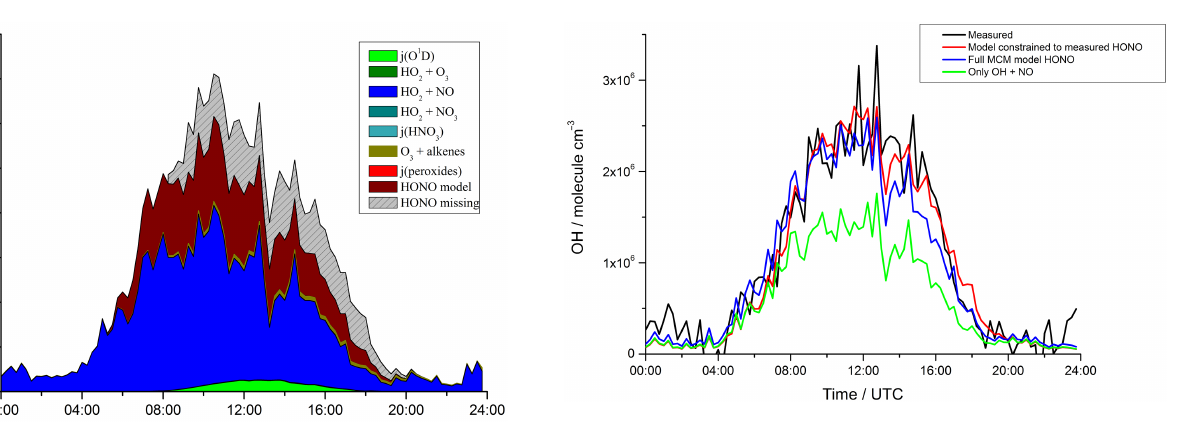
Figure 11. Average diurnal profile of OH showing measured (black), modelled unconstrained to HONO with only NO + OH as a HONO sources (green), modelled unconstrained to HONO in- cluding additional HONO sources (blue – see text for details), and model constrained to measured HONO